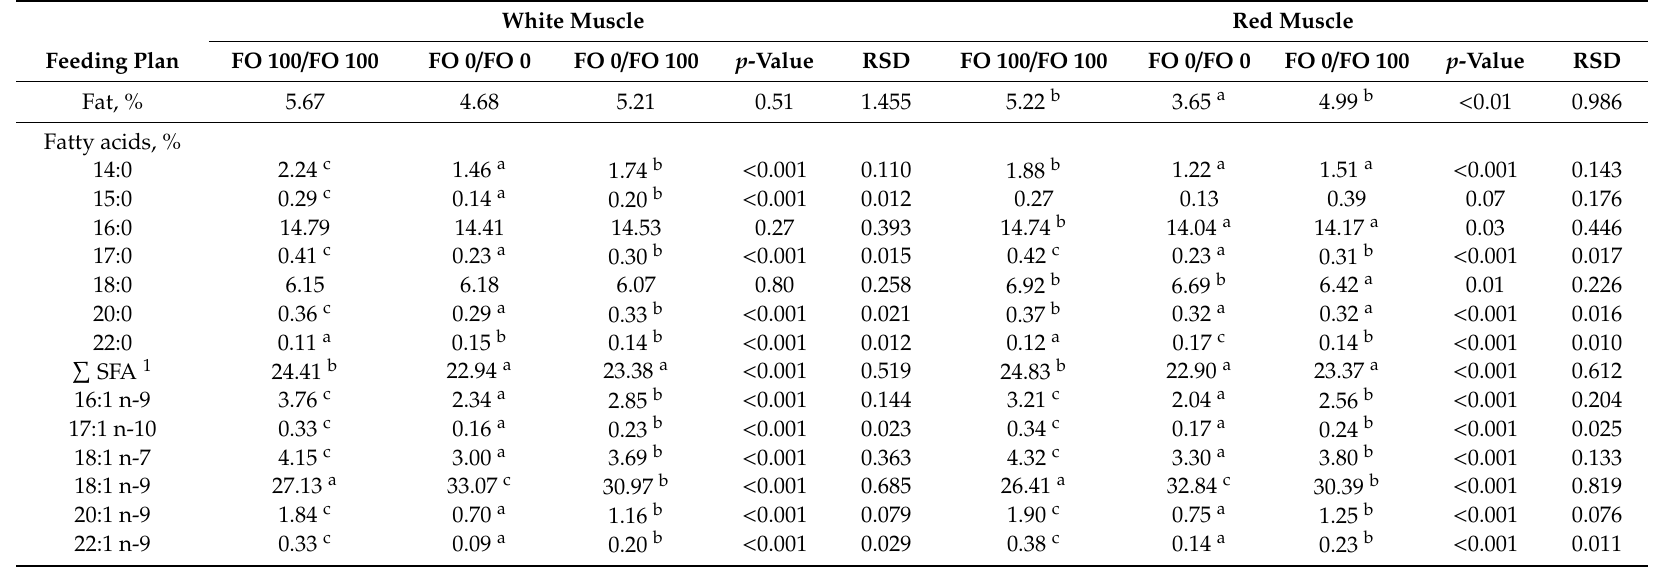
Table 4. Fat content (%) and fatty acid composition (% of total fatty acid content) of white and red muscle in S. dumerili fed FO 100 / FO 100, FO 0 / FO 0, and FO 0 / FO 100 diets after 90 d of wash-out (6 fish per feeding plan): e ff ect of the feeding plan. Values are expressed as least square (LS) means. White Muscle Red Muscle Feeding